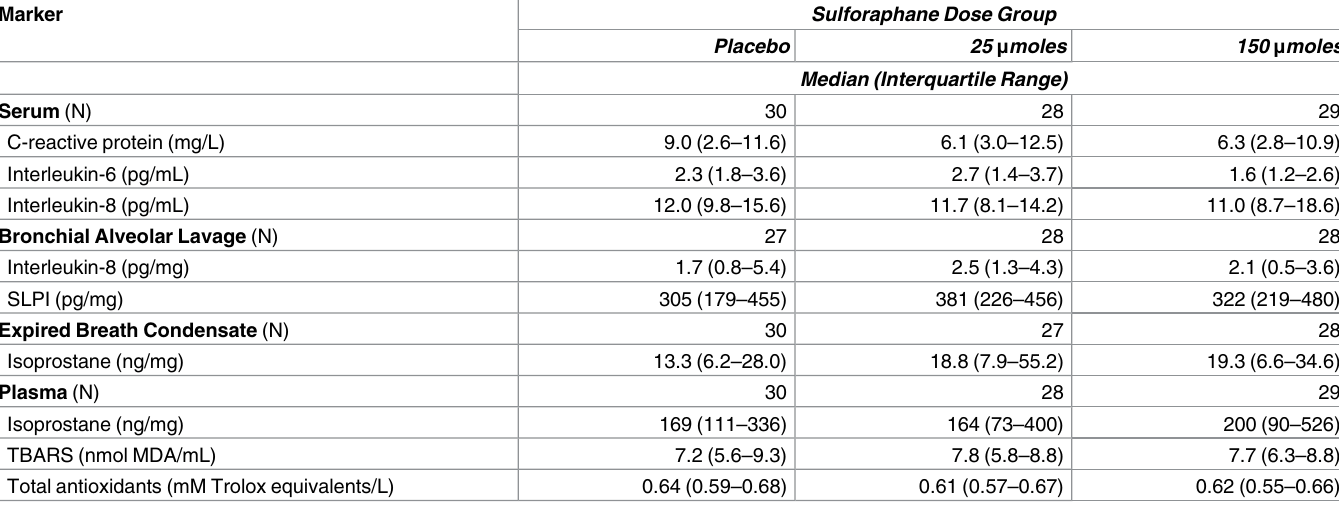
Table 2. Baseline measuresof antioxidants and markersof inflammation by treatment